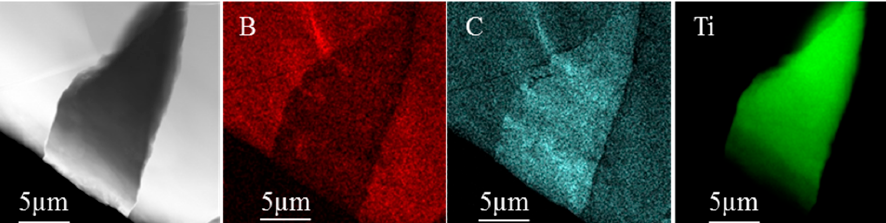
6 of 11 Figure 4. SEM images of fracture surface of composites tested at room temperature and manufactured at: ( a ) 900 °C; ( b ) 1000 °C; and ( c ) 1000 °C with Ti-Al. Regarding the secondary phases formed as products of the reaction between the matrix and the B 4 C particles, a detailed study of their morphology and shapes was carried out only in the specimens manufactured at 1000 °C without intermetallic, since in these specimens, more TiC and TiB were detected by XRD (see Figure 2) and observed in SEM images. The TiC and TiB phases were evaluated at micro/nano-scale via TEM images. Moreover, this specimen was selected (from the three) because